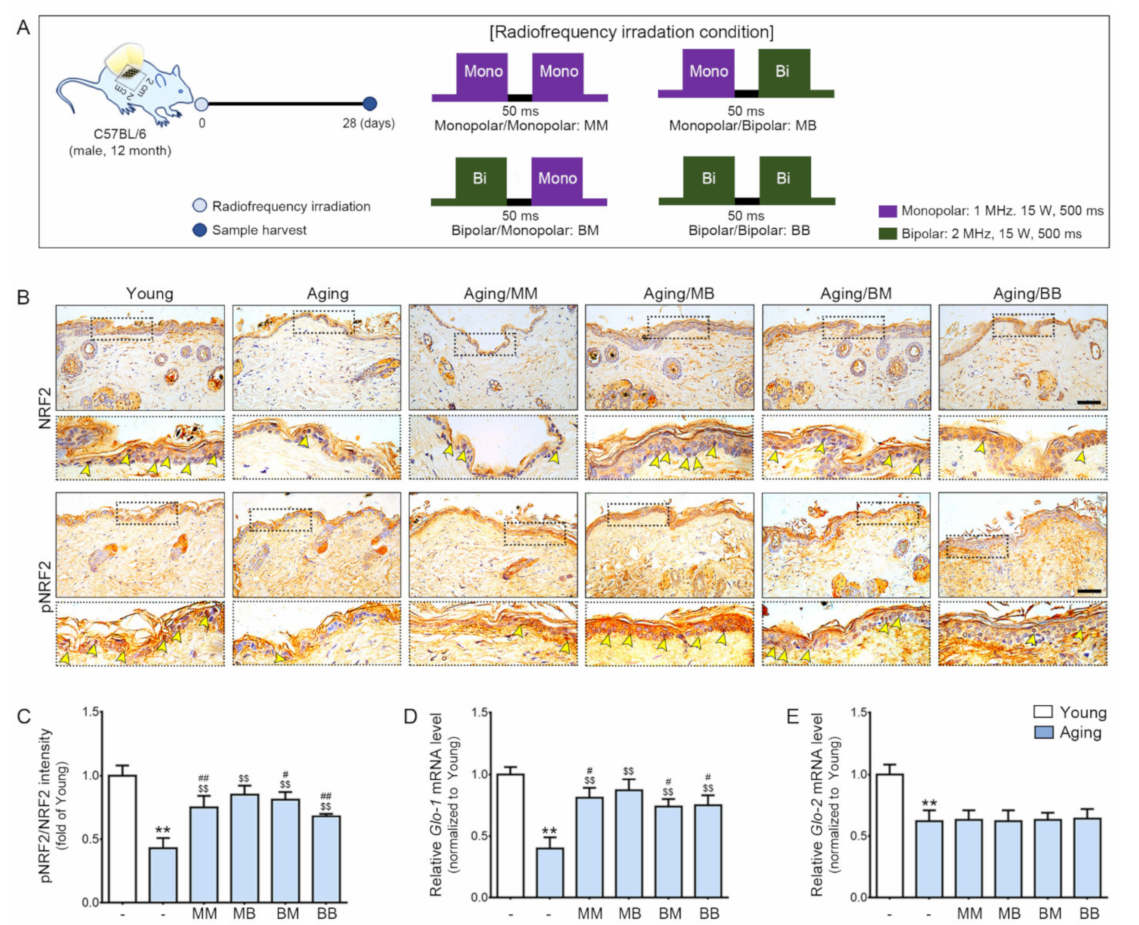
Figure 1. The synergistic effect of pNRF2/NRF2, Glo-1, and Glo-2 expression depending on the combinations of RF modes considered: ( A ) An area of the dorsal skin (2 cm × 2 cm) from the mice in the Young or Aging group without RF radiation or from the mice for each RF mode (MM, MB, BM, or BB) were harvested 28 days after RF radiation. ( B ) NRF2 and pNRF2 expression in the epidermis of the aged mice skin were assessed immunohistochemically (scale bar = 100 µ m). The yellow arrows represent positive signals. ( C ) Quantitative ratios of representative NRF2 and pNRF2 images. ( D , E ) The mRNA expression levels of ( D ) Glo-1 and ( E ) Glo-2 were determined in the skin tissue. The mRNA levels in the mouse skins were validated by qRT-PCR, normalized versus Actb , and expressed relative to levels in the Young group. Data are presented as mean ± standard deviation. **, p < 0.01, vs. Young; $$, p < 0.01, vs. Aging; #, p < 0.05 and ##, p < 0.01, vs. Aging/MB (Mann–Whitney U test). MM, monopolar mode applied twice; MB, application of the monopolar followed by application of the bipolar mode; BB, bipolar mode applied twice; BM, application of the bipolar mode followed by application of the monopolar mode; Glo, glyoxalase; NRF2, nuclear factor erythroid 2-related factor 2; pNRF2, phosphorylated